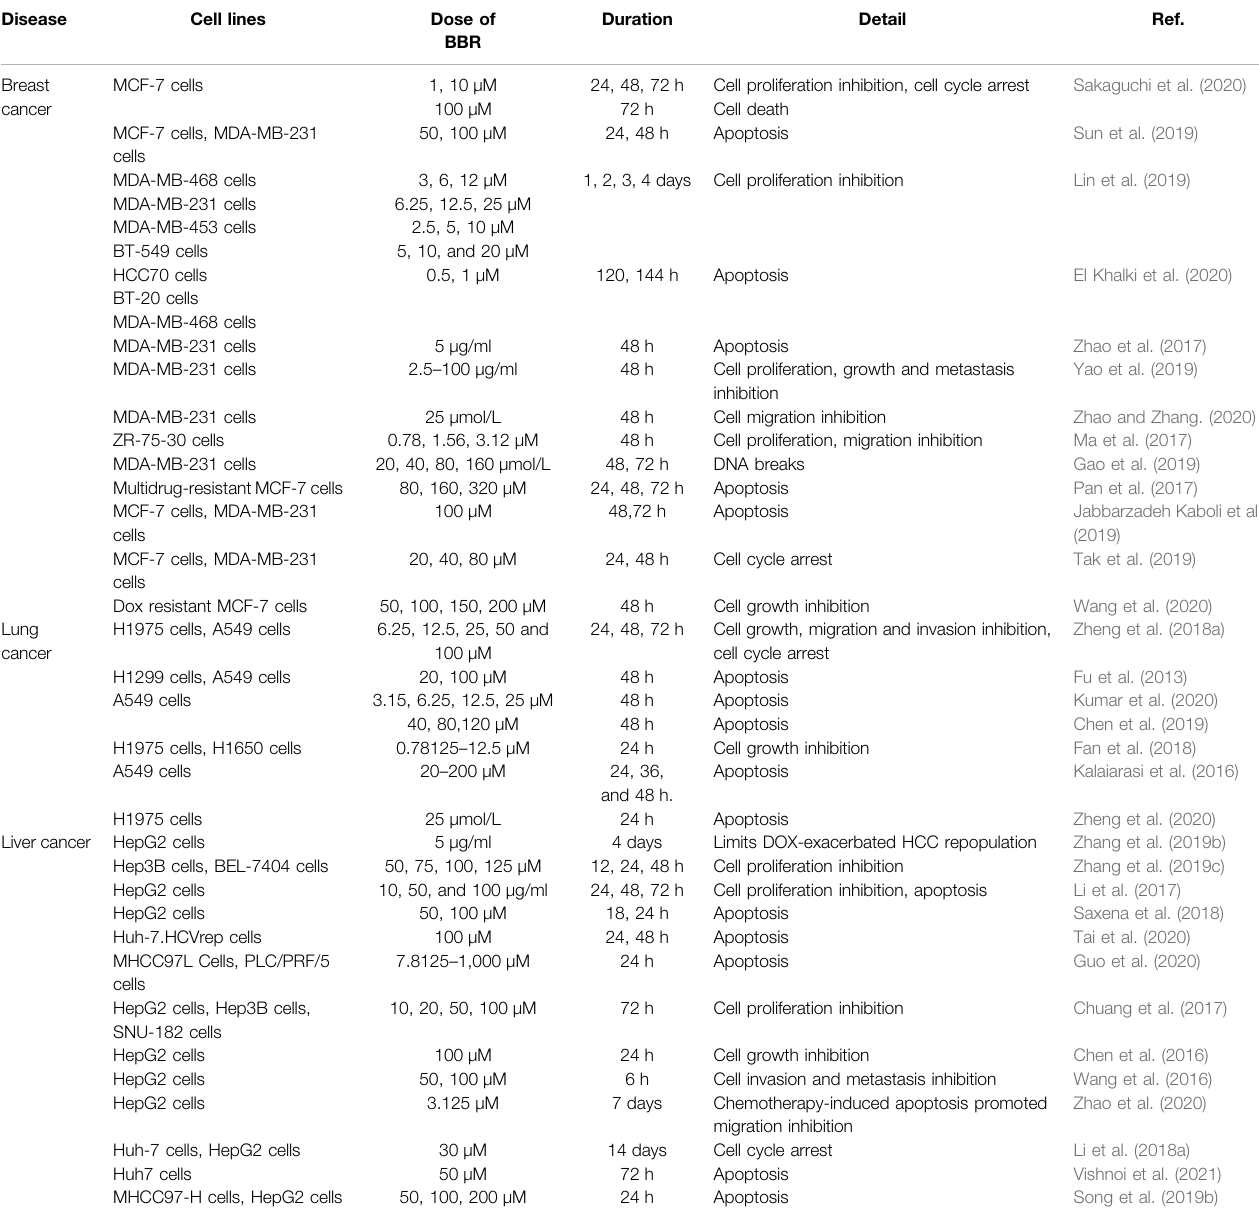
TABLE 3 | Pro-apoptotic effect of BBR on the three cancers in vitro . Disease Cell lines Dose of